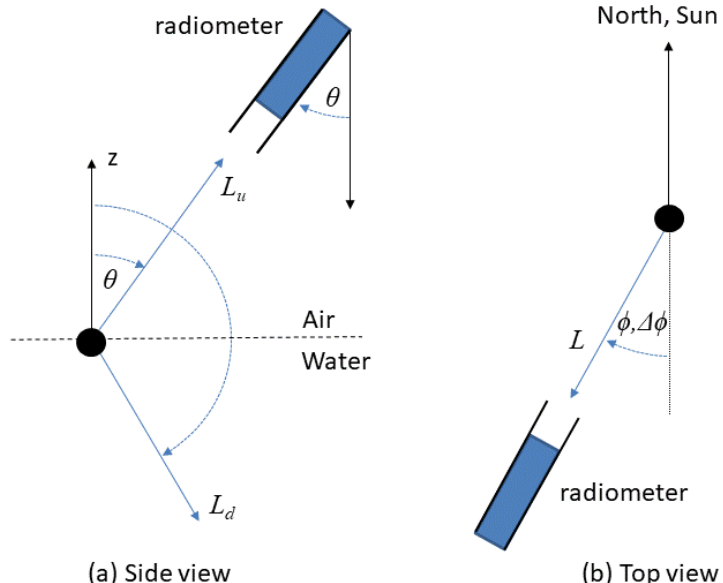
Figure 1. Nadir and azimuth viewing angle conventions illustrated for a reference system centered on the water surface (black dot). ( a ) Viewing nadir angle, θ , is measured from the downward vertical axis: upward radiances are viewed at θ < π /2, downward radiances (from sky and Sun) are viewed at θ > π /2. ( b ) Azimuth viewing angle, φ , and relative azimuth viewing angle, ∆ φ , are measured for viewing directions clockwise from the north and Sun respectively: radiance viewed by a radiometer pointing toward north has an azimuth viewing angle of 0, and radiance viewed by a radiometer pointing toward and away from the Sun have relative azimuth viewing angles of 0 and π , respectively.